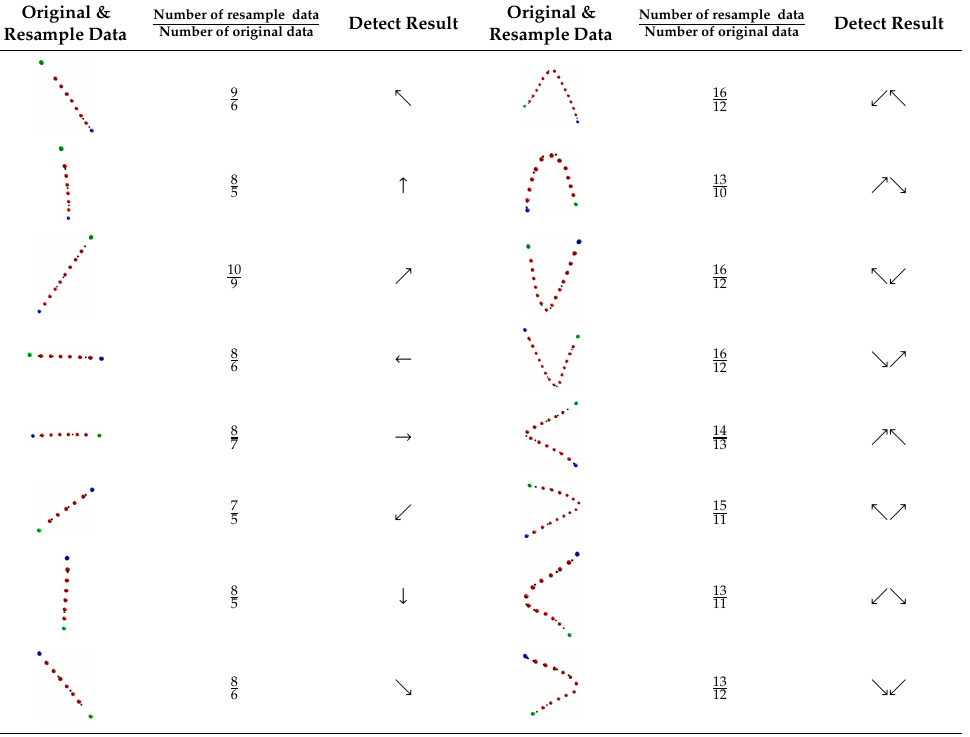
Table 6. Recognition result at under-sampling.